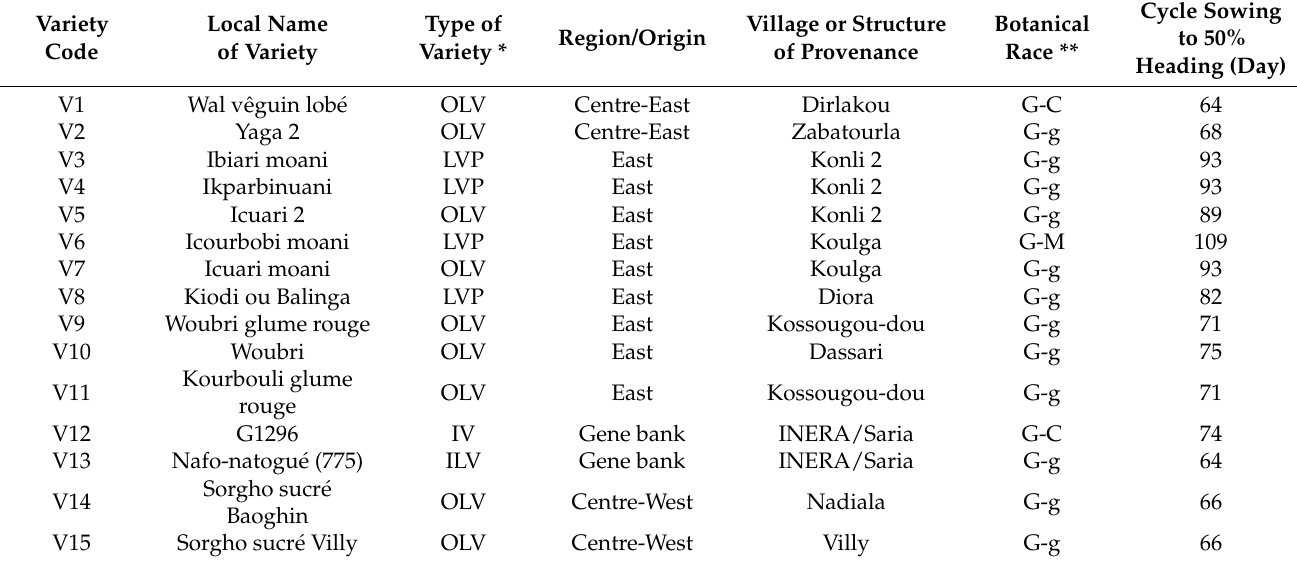
Table 1. Origin and botanical race of the sorghum varieties